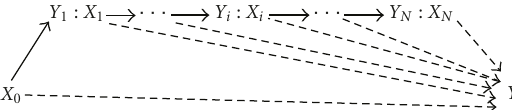
Figure 4: A class of semideterministic multirelay networks.